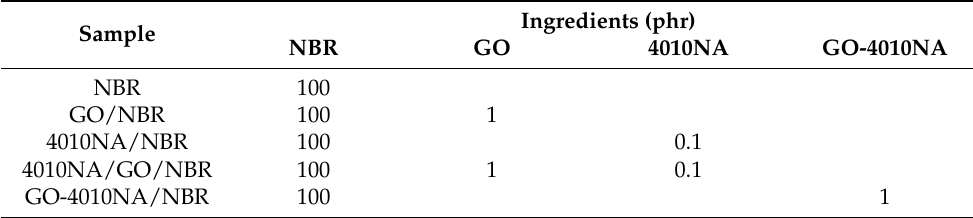
Table 1. The experimental formulae of NBR composites a .